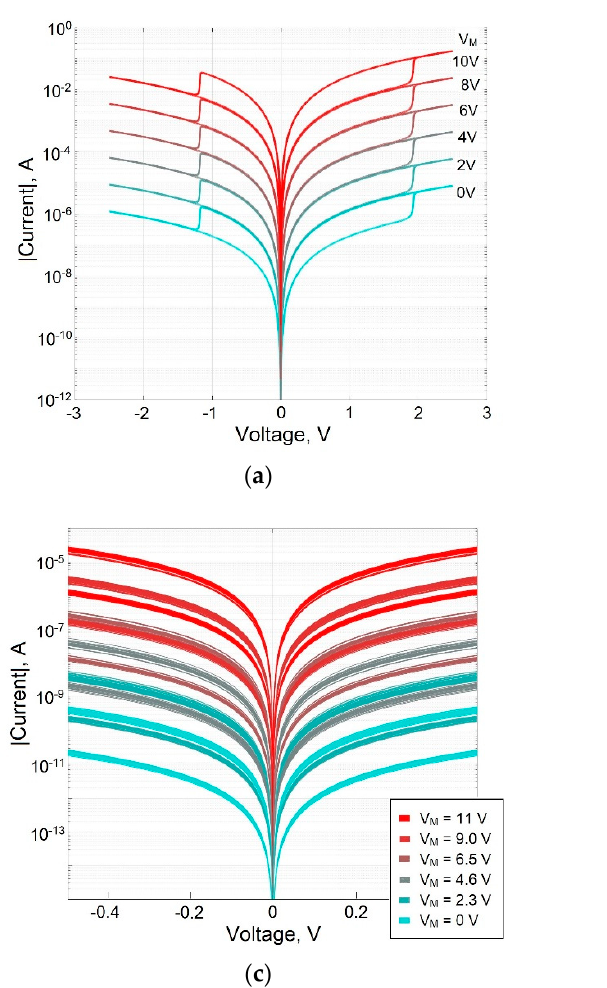
Figure 7. Transients of multilevel tuning of the conductivity of a memristive element.